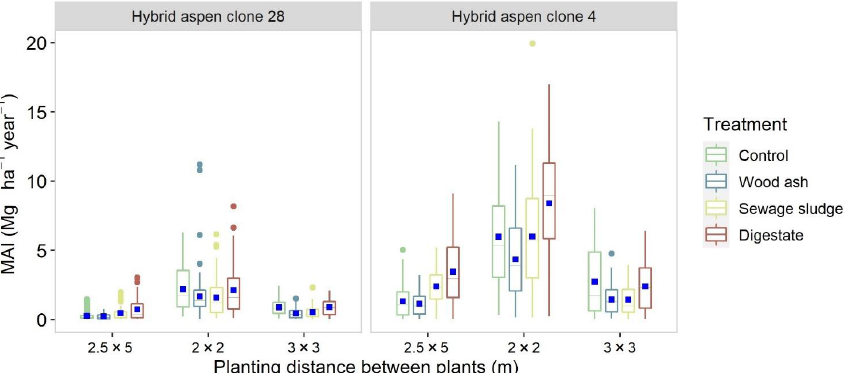
Figure 2. Mean annual increments (MAIs) of above-ground biomass dry matter of eight-year-old hybrid aspen stands depending on planting distance (boxes represent interquartile range; median is shown as center horizontal line in the box; whiskers show minimum and maximum observed values; dots show outliers; mean values are represented by the blue squares). Application of digestate had a positive effect on hybrid aspen yield, except in the cases of the 3 × 3 m plots for both clones and the 2 × 2 m plot for clone 28. Plots where wood ash was applied performed the worst in terms of biomass accumulation across all densities and regardless of clone. Sewage sludge did not have a positive effect in most cases, compared to the control — a positive effect on yield was observed only in planting density of 2.5 × 5 m for both clones; however, this was more likely due to soil differences across fields rather than interaction between density and fertilization treatment. For birch, there were no significant differences between container types when initial planting material height differences were taken into account ( P = 0.09). Birch stands with type 1 planting material produced an average of 1.5 Mg ha − 1 y − 1 and type 2 planting mate-